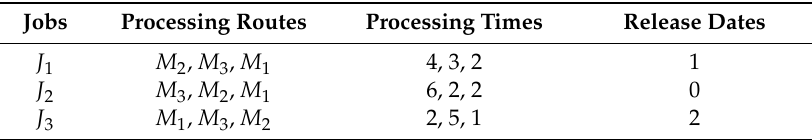
Table 2. Input data of Example